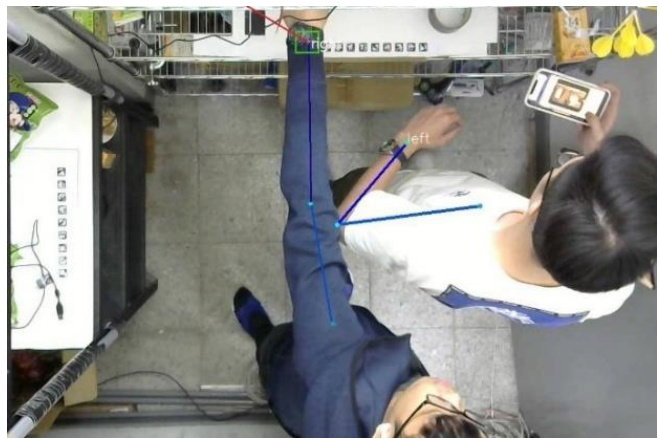
Figure 5. Using OpenPose to determine the purchase status of customers.